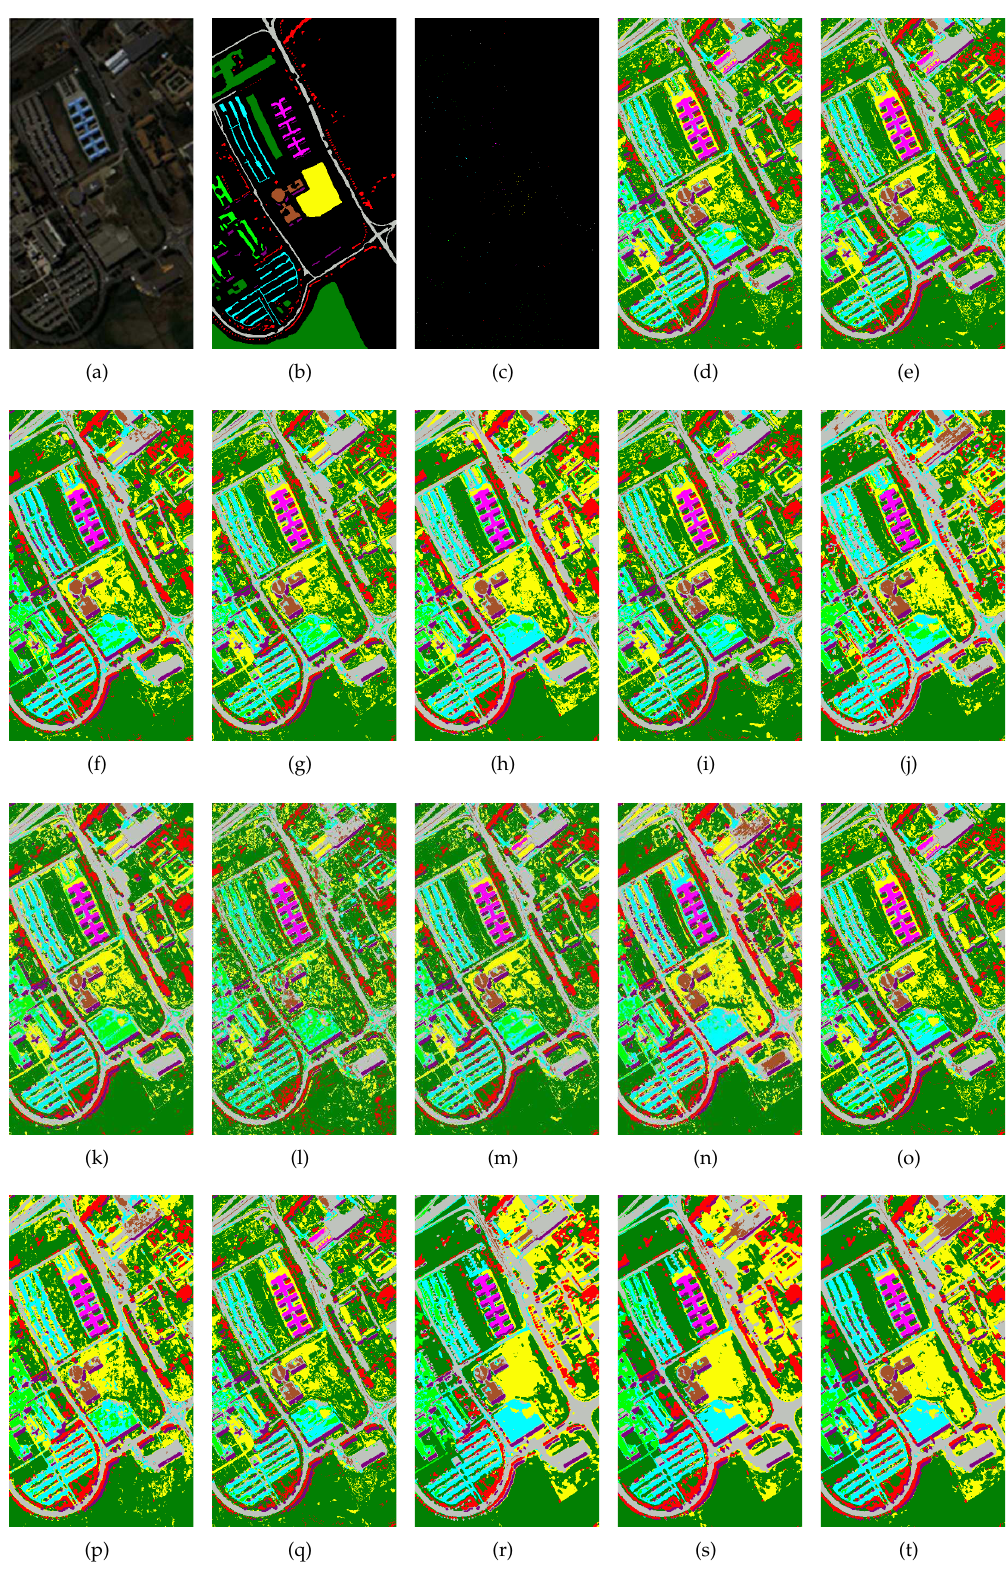
Figure 8. Classification maps of different methods on the PaviaU data set. ( a ) False color image; ( b ) Ground truth; ( c ) Training samples; ( d ) RAW; ( e ) PCA; ( f ) NPE; ( g ) LPP; ( h ) LDA; ( i ) MMC; ( j ) MFA; ( k ) NWFE; ( l ) SPP; ( m ) SDE; ( n ) SME; ( o ) SMML; ( p ) MMDA; ( q ) DSSM; ( r ) LPNPE; ( s ) WSSGLDA; ( t )